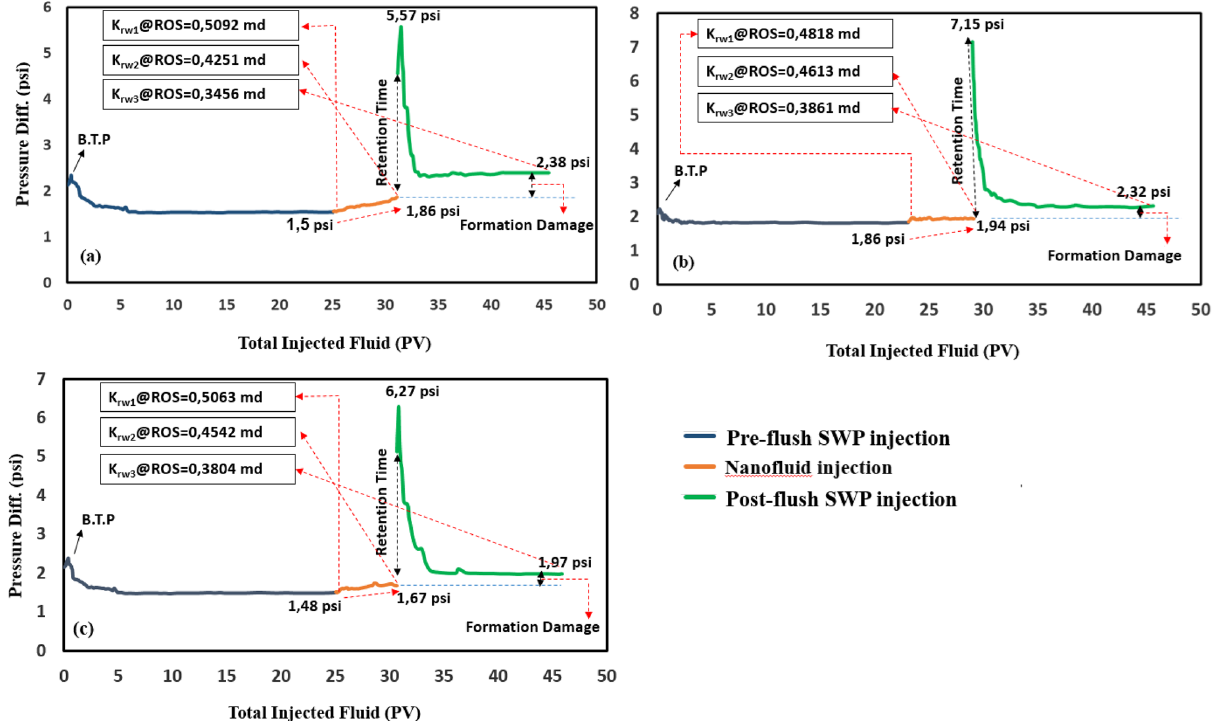
Figure 5. Differential pressure profile during pre-flush water flooding, nano flooding and post-flush water flooding again across the core plugs at 90 °C and 750 psi and retention time of 72 h ( a ) core D, SWP/500-PE-cit- ANPs nanofluid/retention time/SWP injection scenario ( b ) core E, SWP/500-PE-cit-AQDs nanofluid/retention time/SWP injection scenario ( c ) core F, SWP/1000-PE-cit-AQDs nanofluid/retention time/SWP injection